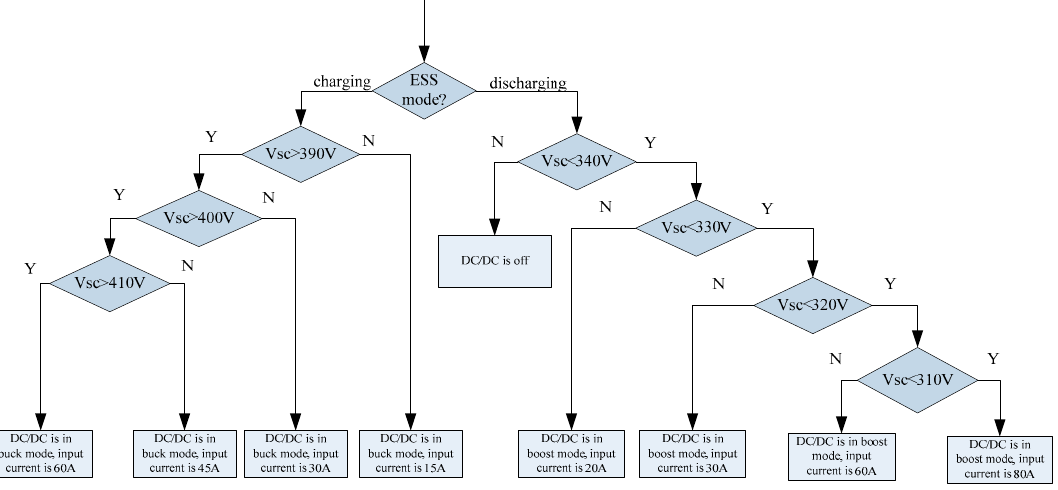
Figure 22. The CS of SC/battery HESS in real PTHEB.